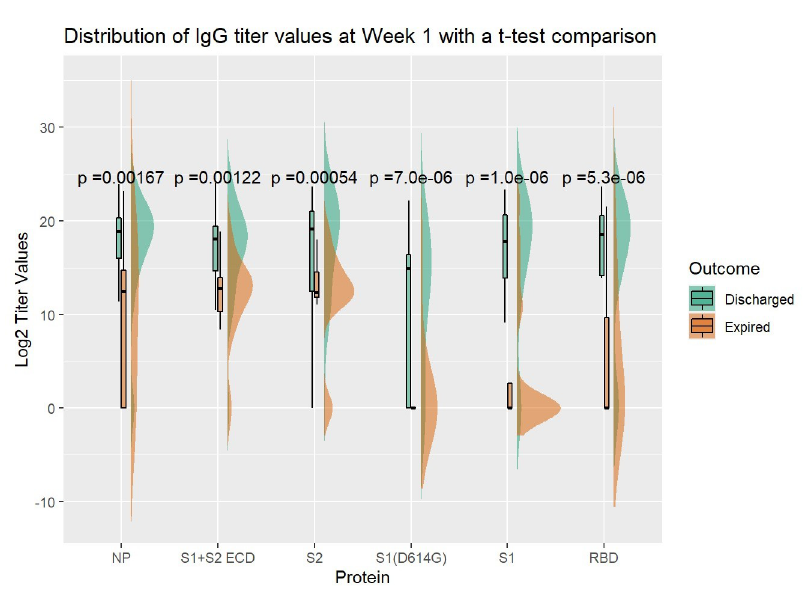
Fig 2. Comparison of Week1 (0 to 7 days) After Onset Anti-SARS COV2 IgG Antibody Titers Between Discharged and Expired Groups. Density and box plots show distribution of specific IgG titer values (log transformed) at week 1 after onset targeting SARS CoV2 NP and five spike protein components, S1+S2 ECD, S2, S1 (D614G), S1 and RBD. The expired (orange) and discharged (green) groups were shown with t-test comparison p- values.